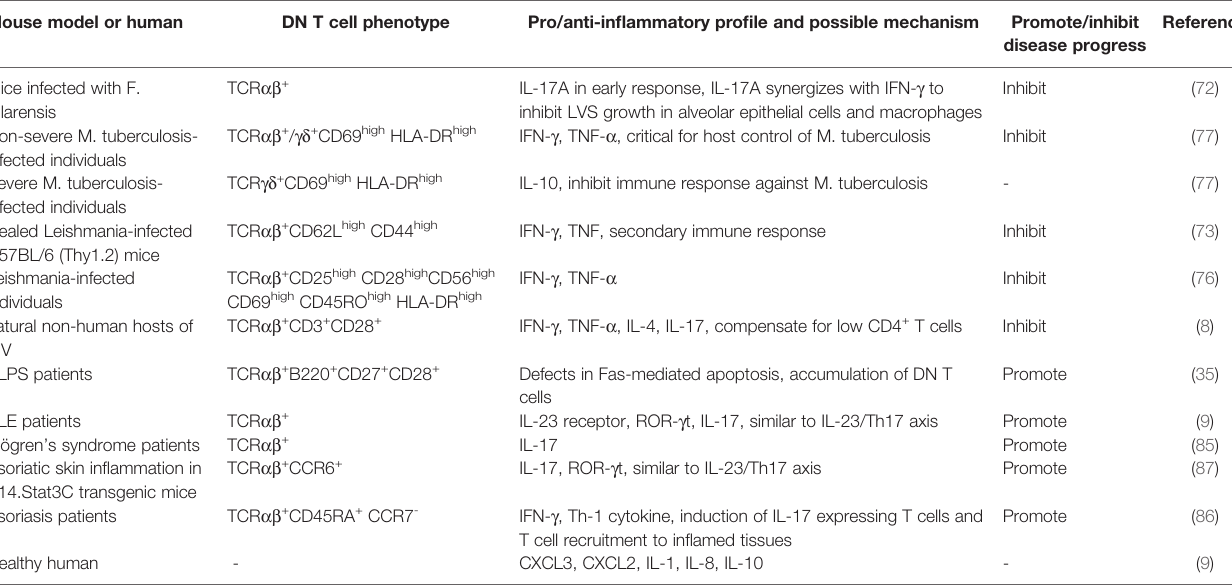
TABLE 2 | T helper-like DN T cell in response to in fl ammation. Mouse model or